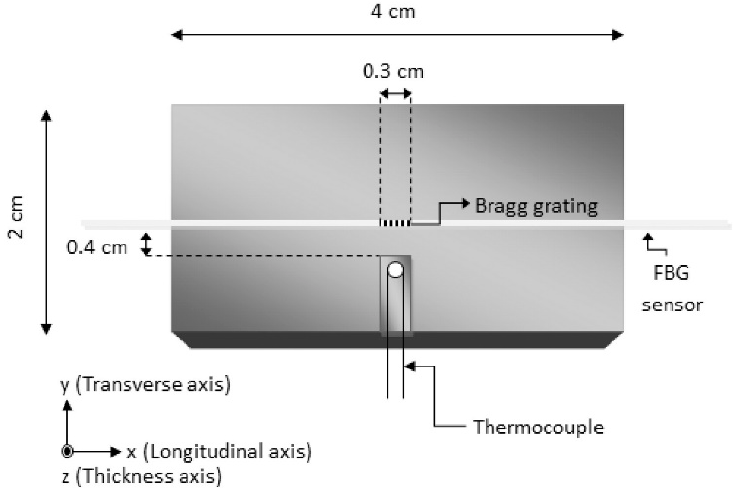
Figure 10. Schematic of a 3D printed neat TP with the location of the FBG sensor and the thermocouple [72] (copyright (2016), with permission from Elsevier).